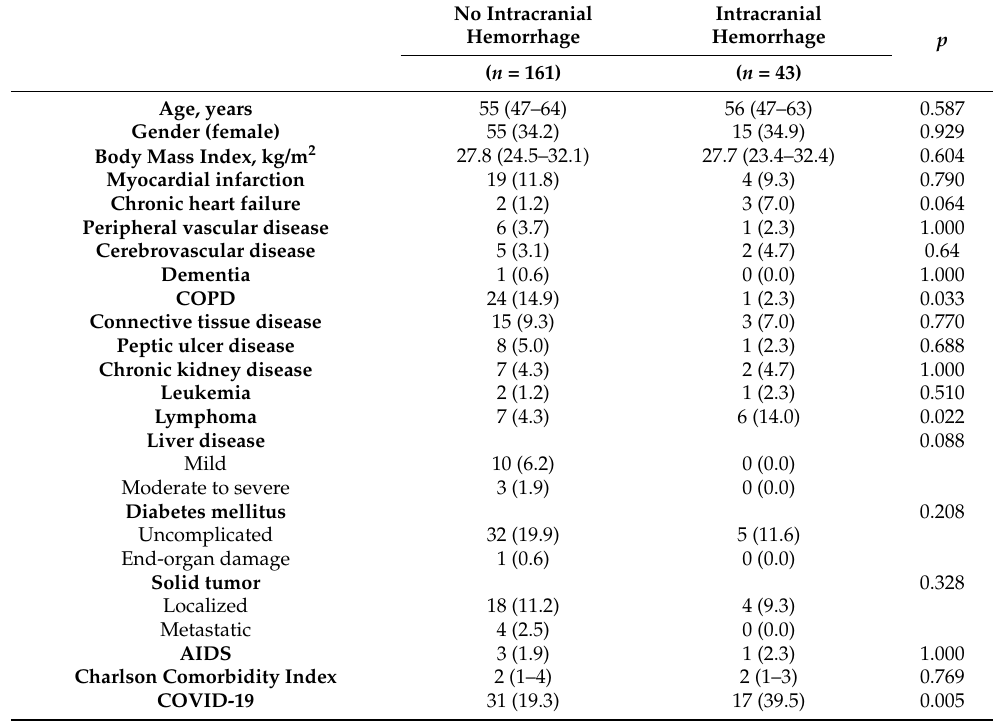
Table 1. Demographic and clinical